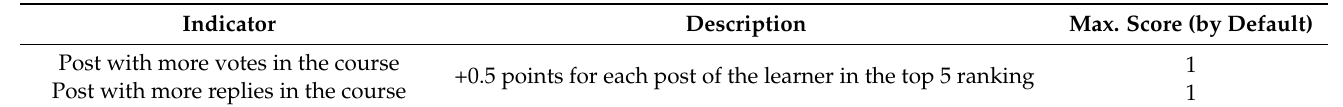
Table 3. Extra Points to the Final Forum